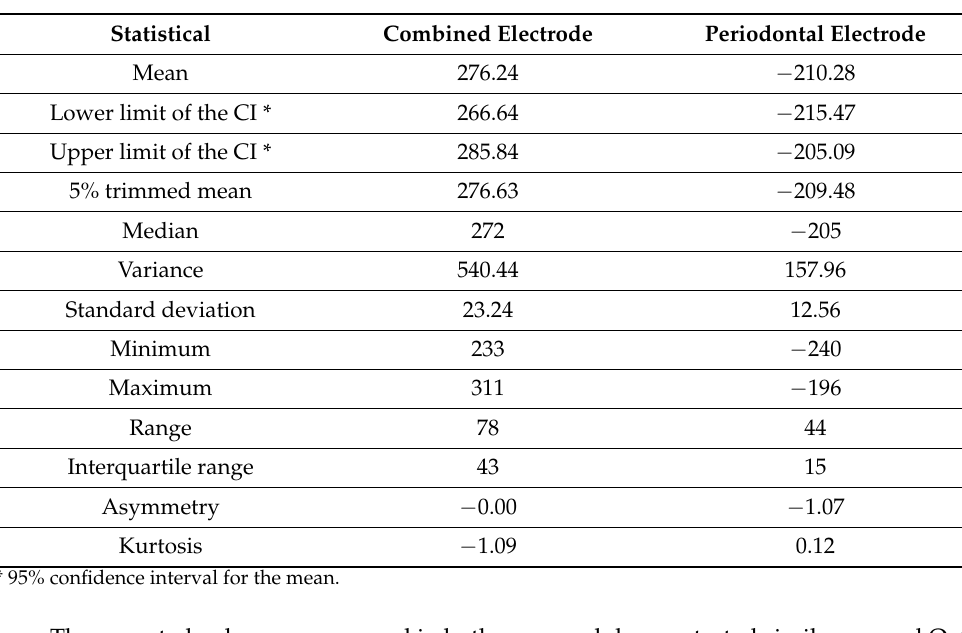
( b ) Figure 6. Box plot of the total bone-to-implant contact (BIC) obtained with control and UVC- treated surfaces. Plots show the lower (Q1), median (Q2), and upper (Q3) quartiles. The whiskers indicate the highest and lowest observations. ( a ) Box plot of the combination electrode potential in mV. ( b ) Box plot of the periodontal electrode potential in mV. These differences were statistically significant according to the paired Student’s t-test (Table 3).